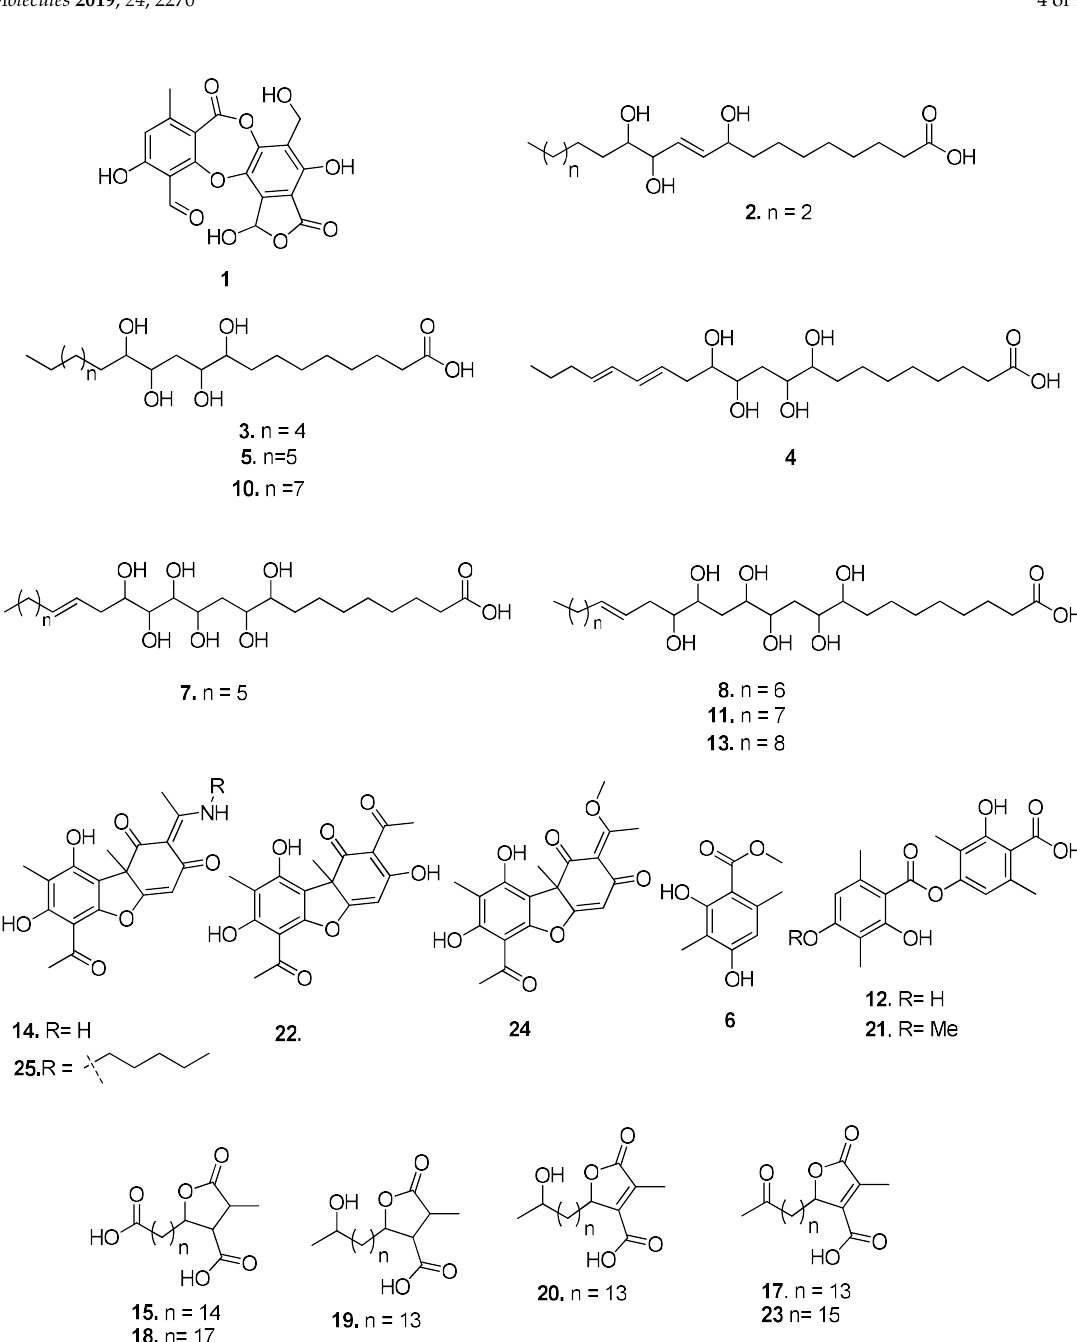
Figure 2. Compounds identified through UPLC-ESI-QTOF-MS/MS in U. longissima acetone extract.